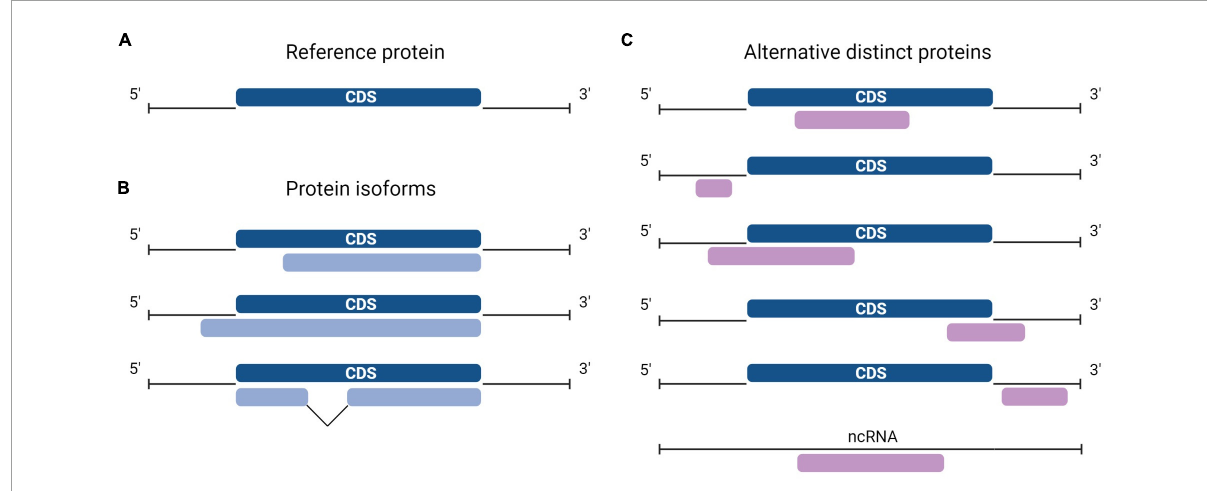
FIGURE1 Diversity in the location of protein-coding sequences (CDSs). (A) In a typical messenger RNA (mRNA), the canonical protein CDS, or CDS (dark blue) encodes the reference protein (RefProt) and is flanked by the 5 (cid:48) - and 3 (cid:48) - untranslated regions (UTRs). (B) Protein isoforms from the RefProt (light blue) may result from translation initiation at upstream or downstream initiation sites, or from the translation of alternatively spliced transcripts. (C) In addition to the conventional CDS, an mRNA may carry other CDSs or alternative open reading frames (ORFs) (purple), alternative ORFs (AltORFs) are present in regions of the transcriptome previously annotated as non-coding: 5 (cid:48) - and 3 (cid:48) -UTR, overlapping the CDS out-of-frame, and transcripts annotated as non-coding RNA (ncRNA).